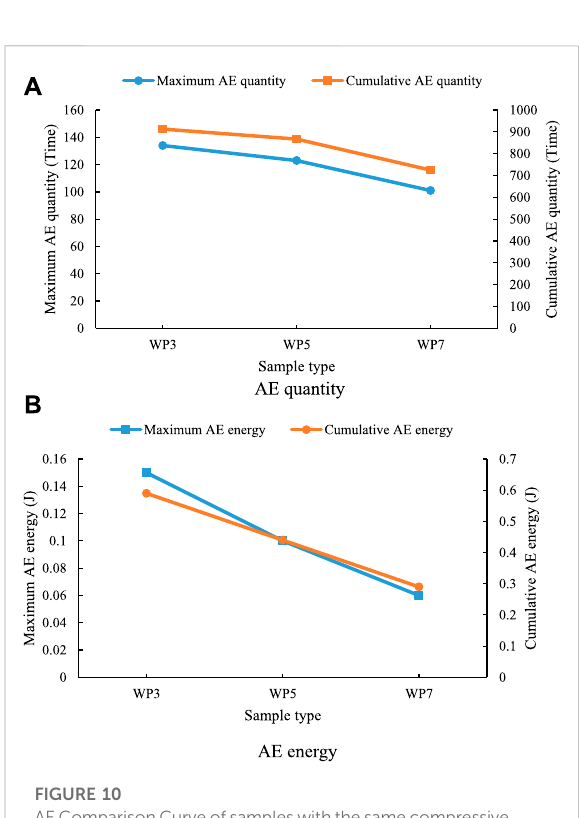
FIGURE 10 AEComparisonCurve ofsampleswiththesamecompressive strength and different lower boundaries water pressure.